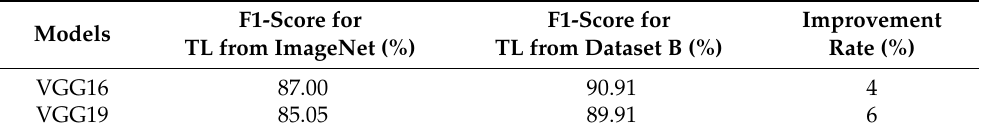
Table 14. Improvement rate after transfer learning from unlabeled data (Dataset